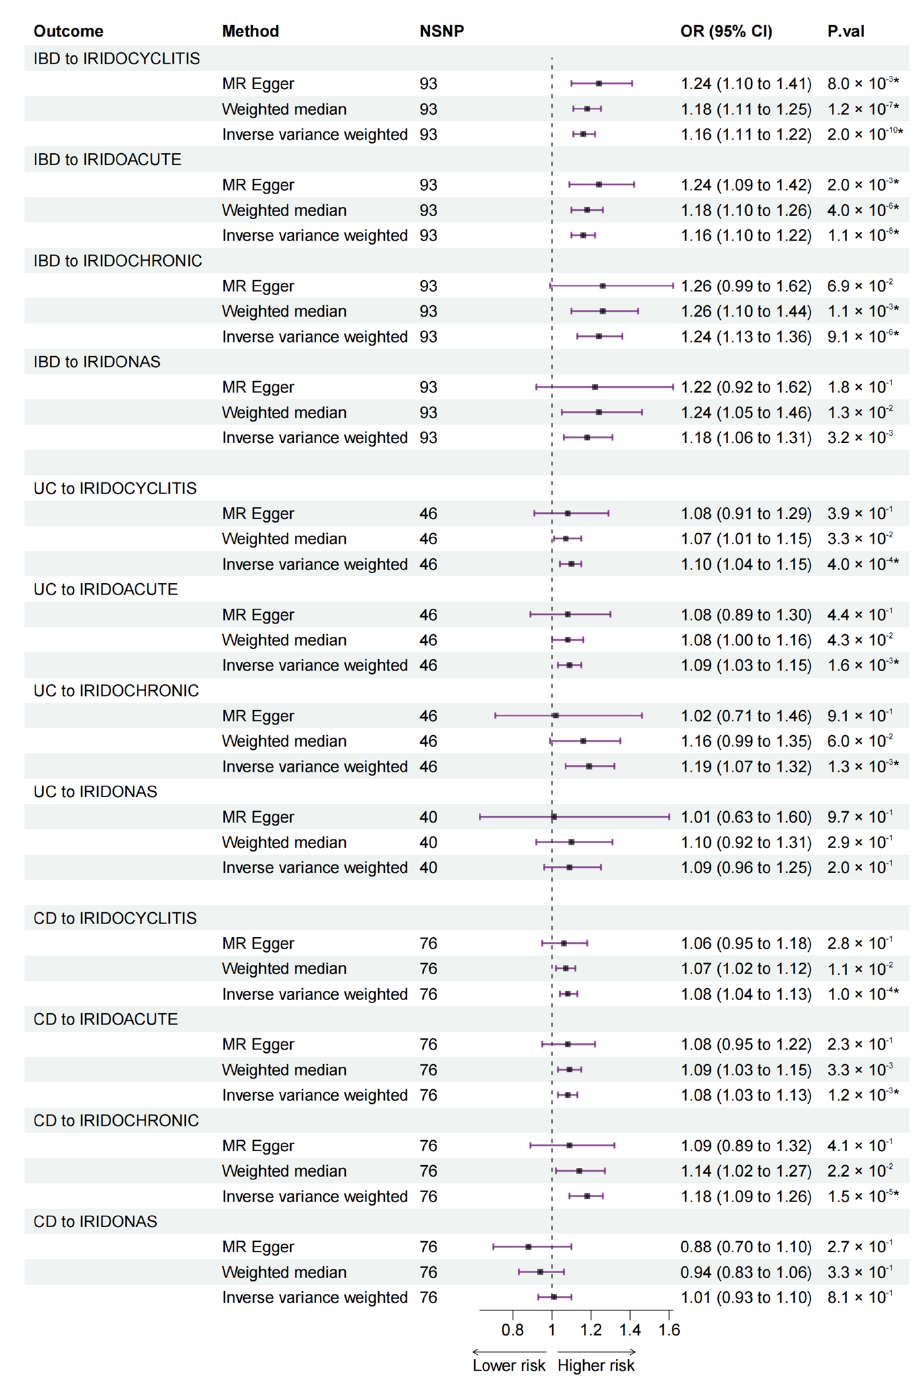
Figure 2. MR estimates from IBD (including UC and CD) to IC in bidirectional MR. MR: Mendelian randomization; IBD: inflammatory bowel disease; UC: ulcerative colitis; CD: Crohn’s disease; IC: iridocyclitis; NSNP: number of single nucleotide polymorphism; OR: odds ratio; CI: confidence interval; IRIDOCYCLITIS: IC as a whole; IRIDOACUTE: acute and subacute IC; IRIDOCHRONIC: chronic IC; IRIDONAS: other and unspecified IC. *: p -values of statistical significance (<0.0021) after Bonferroni